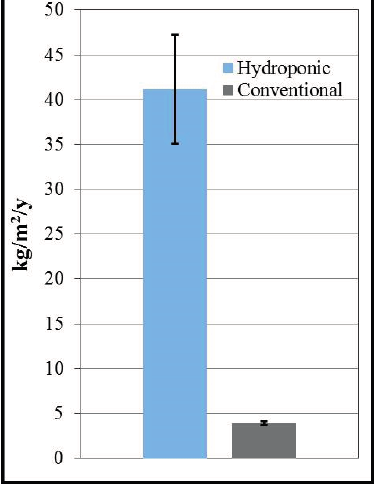
Figure 1. Modeled annual yield in kilograms per square meter of lettuce grown in southwestern Arizona using hydroponic vs. conventional methods (Error bars indicate one standard